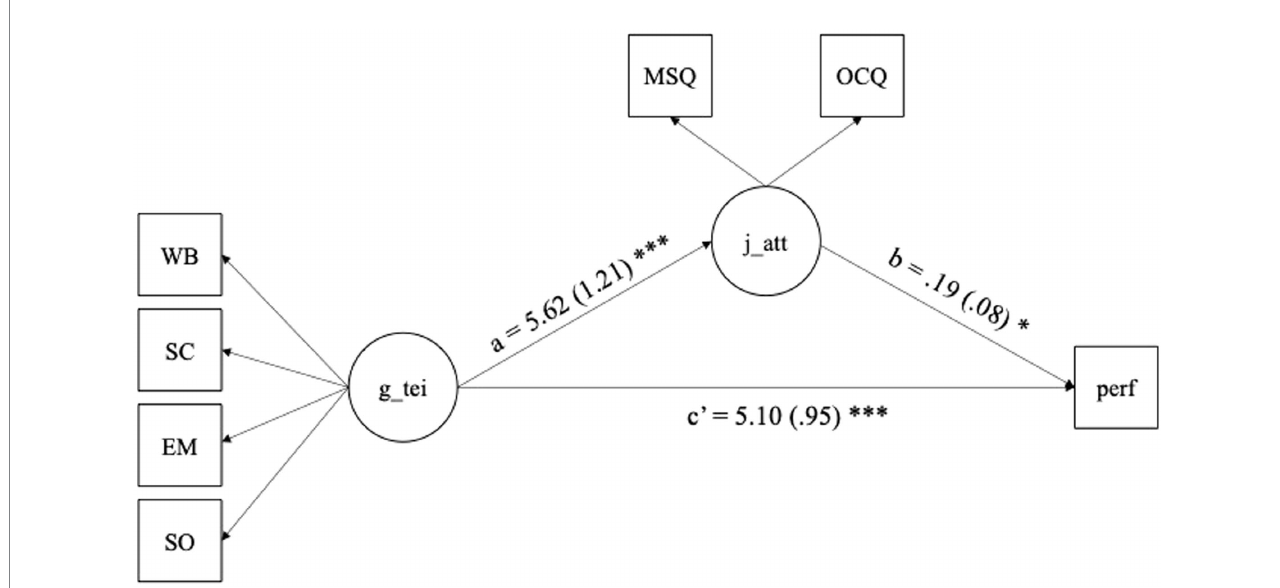
FIGURE 1 The Mediation Model. a Effect of trait EI on job attitudes. b Effect of job attitudes on job performance. c’ Direct effect of trait EI on job performance. Indirect effect of trait EI on job performance (rounded to two decimals) = a x b = 5.62 x .19 = 1.07. The number before the brackets is the estimated effect (associated standard error) rounded to 2 decimal places, g_tei = Global trait EI, j_att = Job attitudes, perf = Job Performance, MSQ = Job satisfaction score, OCQ = Organizational commitment score, WB = Well-being, SC = Self-control, EM = Emotionality, SO = Sociability. * p < 0.05; ** p < 0.01; *** p < 0.001.